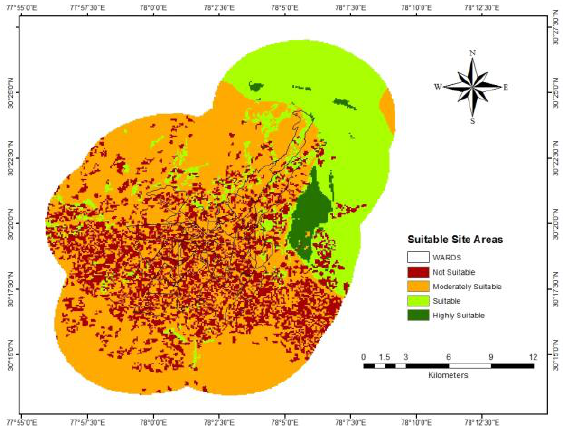
Figure 10. Suitable sites for solid waste disposal (AHP-